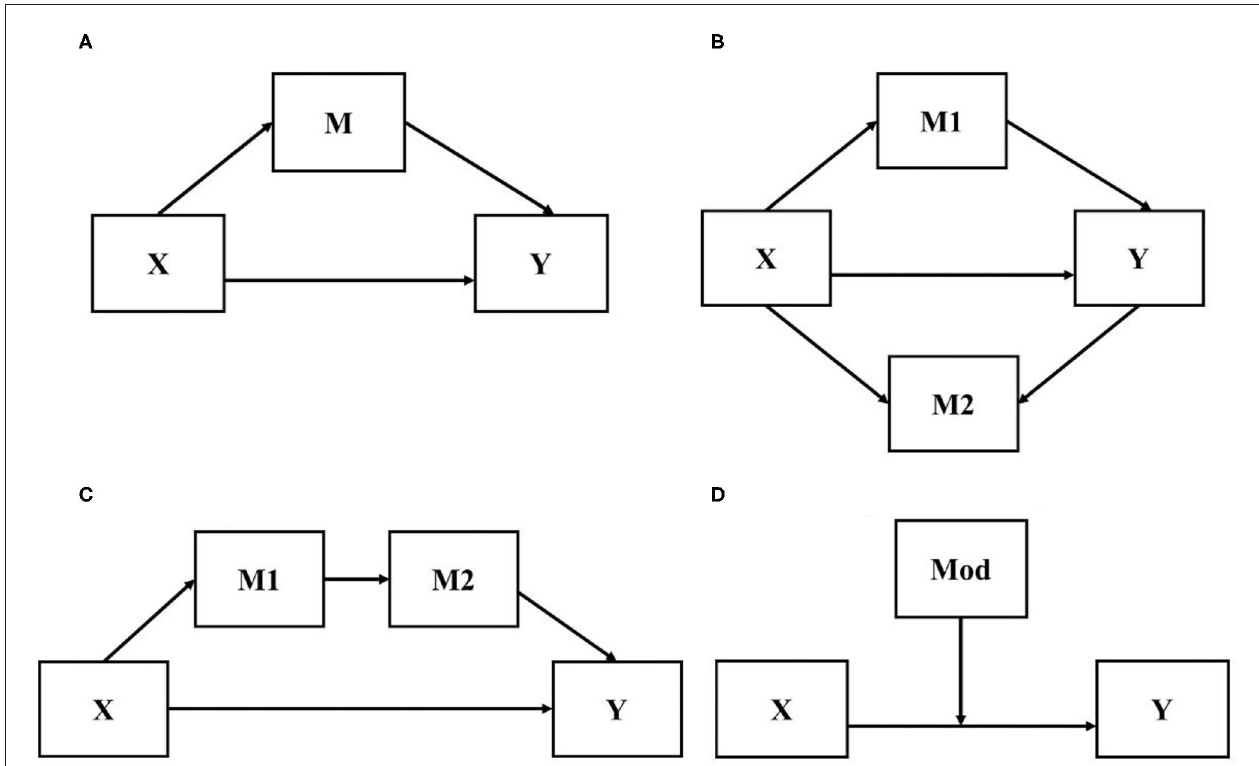
FIGURE 4 | Types of Meditation and Moderation Models. (A) Simple mediation. (B) Parallel mediation. (C). Sequential mediation. (D) Moderation. X = independent variable (mostly the form of therapy or intervention), M = Mediator (the change factor operationalized into a mediator), Y = dependent variable/outcome (e.g., well-being), Mod = Moderator (for additional mediation and moderation models see Hayes,